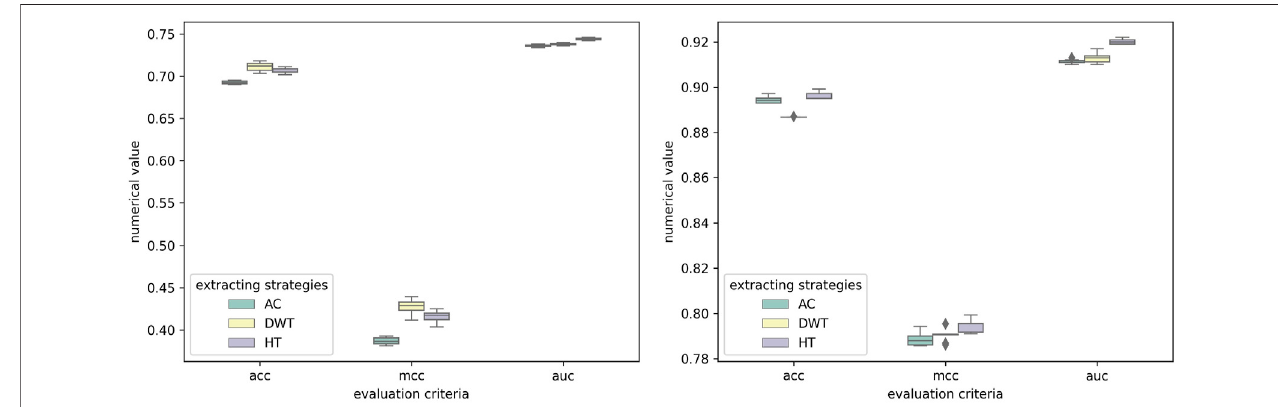
FIGURE 8 | Experimental results of SAWRPI on RPI369 and RPI488 datasets with different feature extracting strategies. The result of SAWRPI on RPI1807 is shown in Supplementary Material .